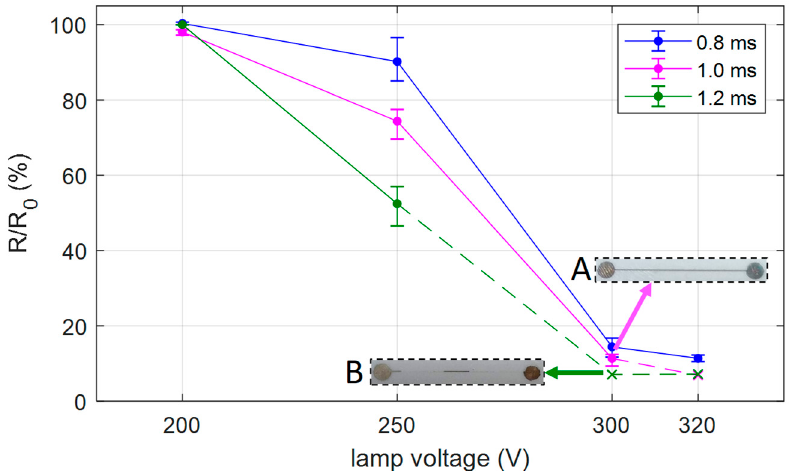
Figure 3. Ratio between the resistance measured after ( R ) and before ( R 0 ) the sintering process. Each point is the average ratio of the stripes sintered with the same process and the error bar is their span. The inset A shows the aspect of the stripe after the sintering process with the best setting (lamp voltage = 300 V, pulse width = 1.0 ms). The cross symbol indicates that some lines were damaged during the process. If the line is damaged (inset B), the resistance is considered infinite and it is not included in the average calculation.